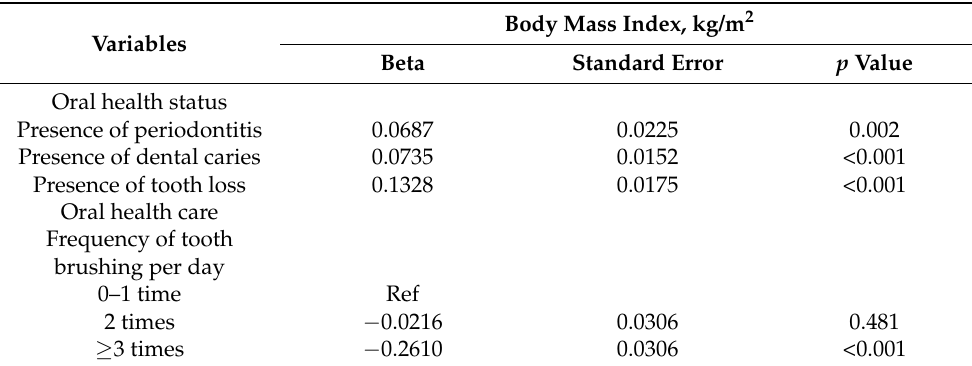
Table 4. Association of periodontitis and oral health indicators with body mass index.